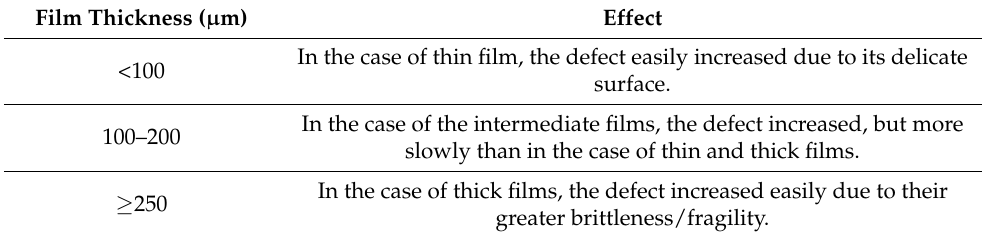
Table 2. End damage